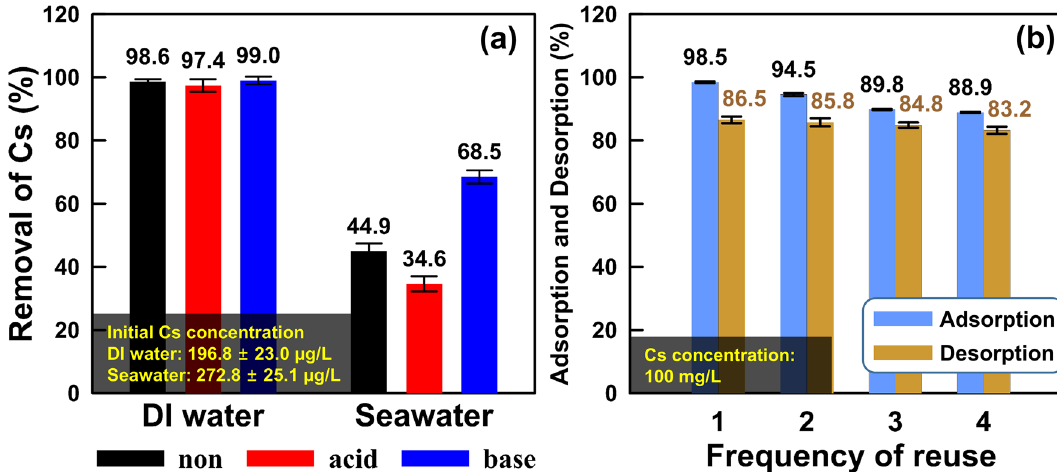
Figure 5. The Cs removal efficiency of Cs-containing DI water and seawater using ( a ) each activated opaline mudstone, and ( b ) the frequency of reuse using base-activated opaline